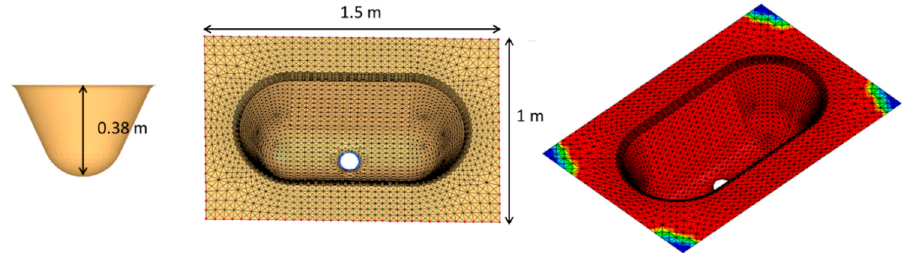
Figure 12. Geometry, mesh and injection simulation of composite reservoir.